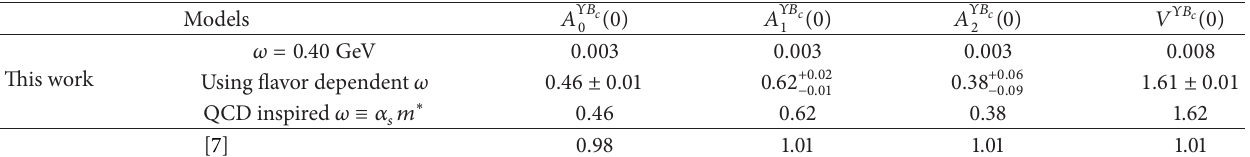
Table 8: Form factors of Υ → 𝐵 𝑐 transitions.